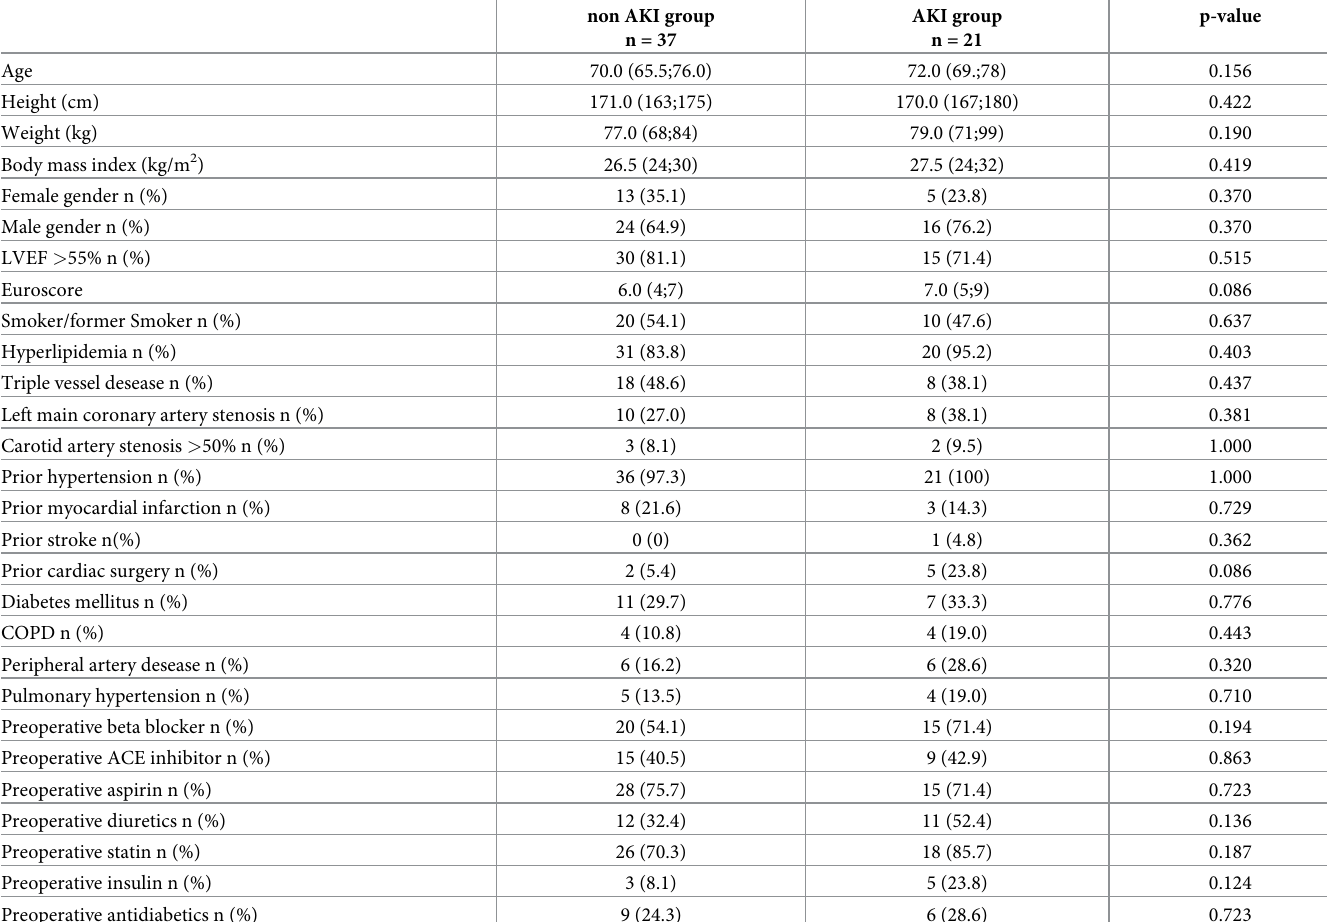
Table 1. Association of demographics and preoperative situation for non-AKI group an AKI